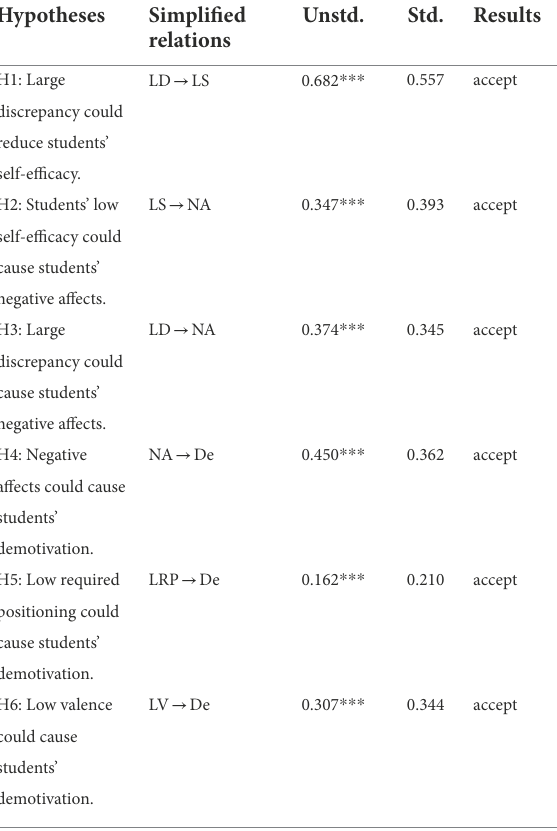
TABLE 10 Results of tested hypotheses.